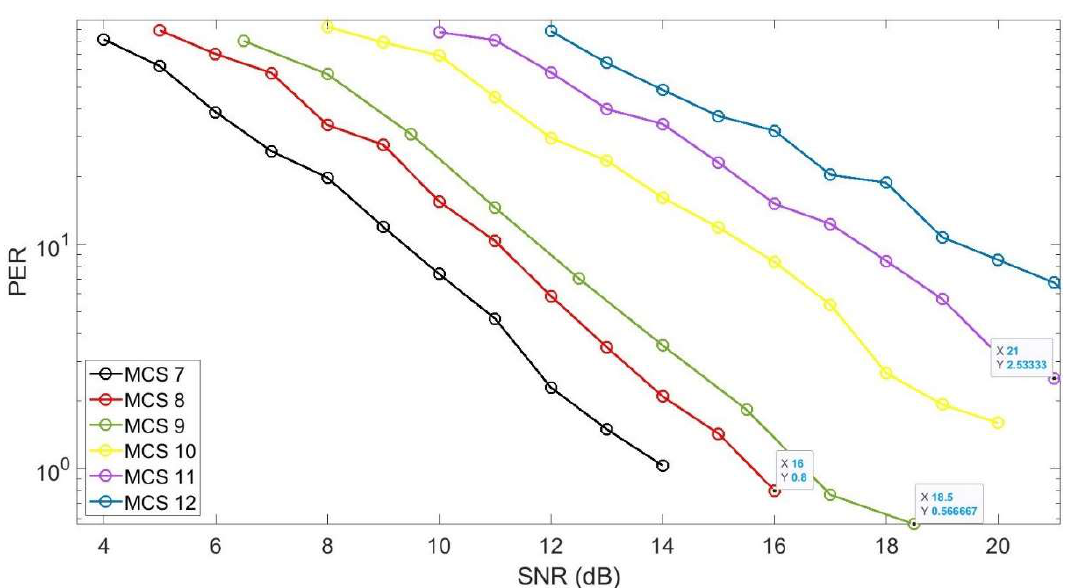
Figure 5. Link2 performance.